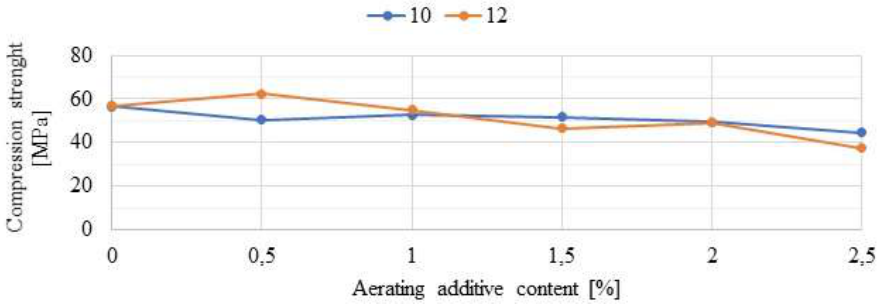
Figure 6. Series no. 10, 12 - Dependence of the amount of aerating additive on compressive strength.